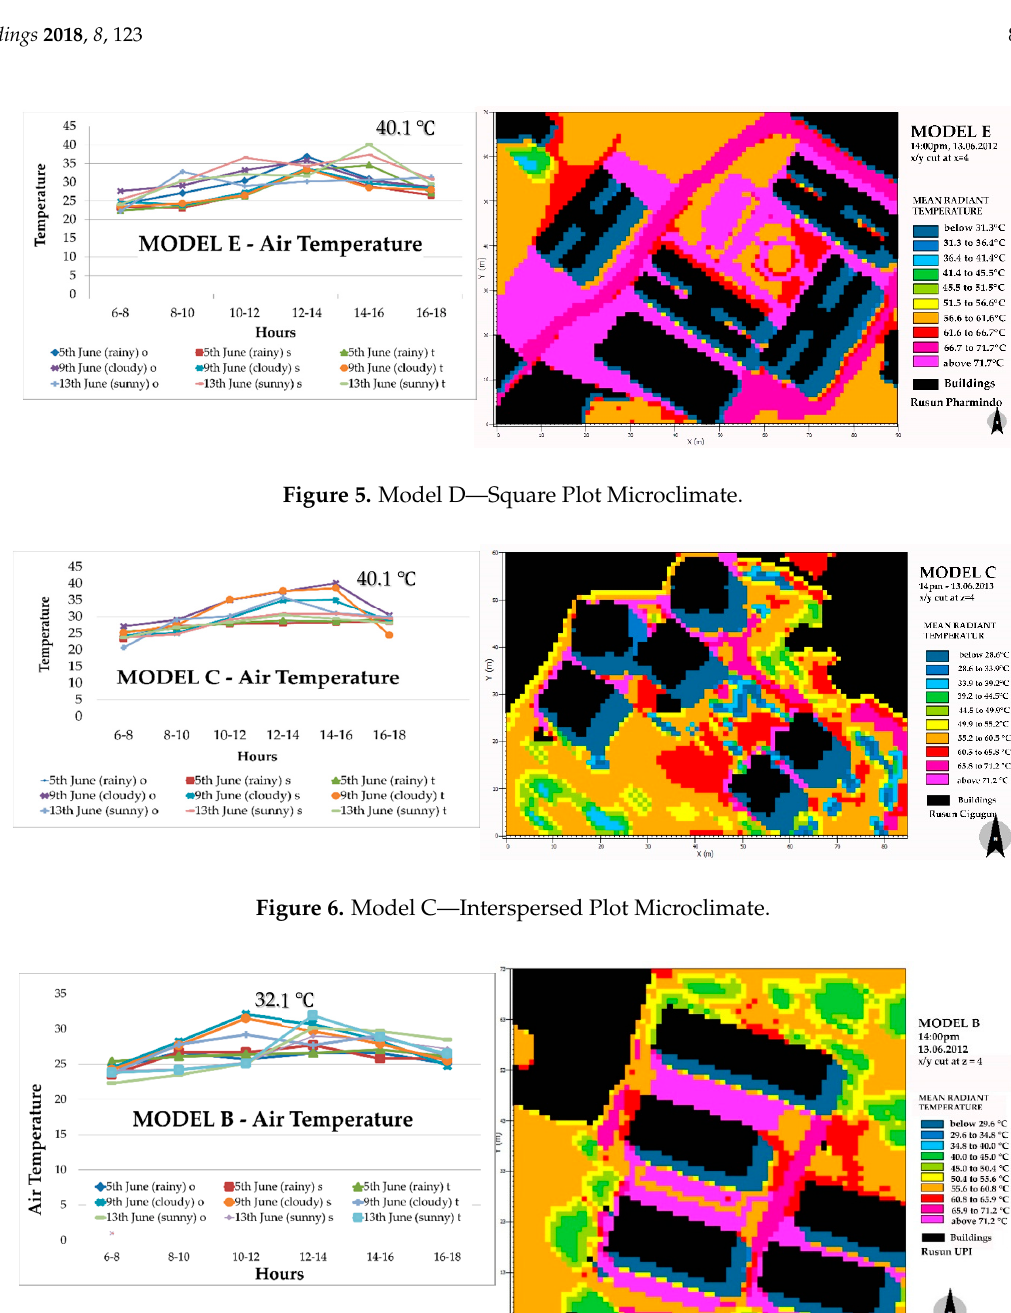
Figure 7. Model B—Parallel Plot Microclimate. Buildings 2018 , 8 , x FOR PEER REVIEW